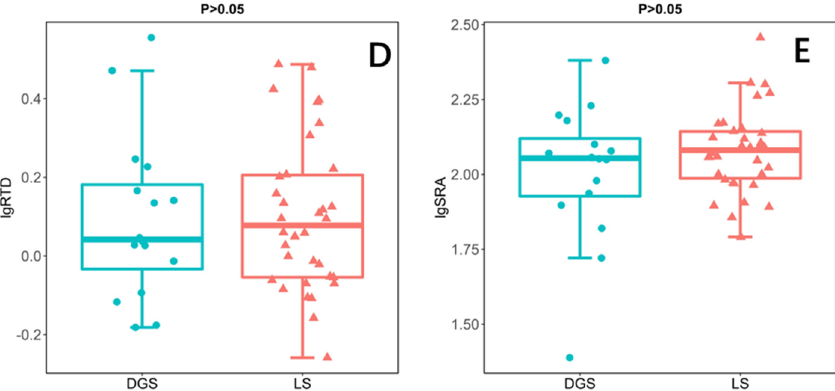
Figure 2. Results of independent sample t-test illustrating the differences between species rooting in loose sand (LS; n = 34) or rooting in dense or gravelly sand (DGS; n = 16) in the in the cold desert of the Chinese Junggar Basin in 2022. ( A ) difference in maximum rooting depth (MRD), ( B ) difference in specific root length (SRL), ( C ) difference in root diameter (RD), ( D ) difference in root tissue density (RTD), ( E ) difference in specific root area (SRA). p < 0.05 indicates significant difference between species rooting LS and species rooting DGS. The values for each species represent 10 plants.